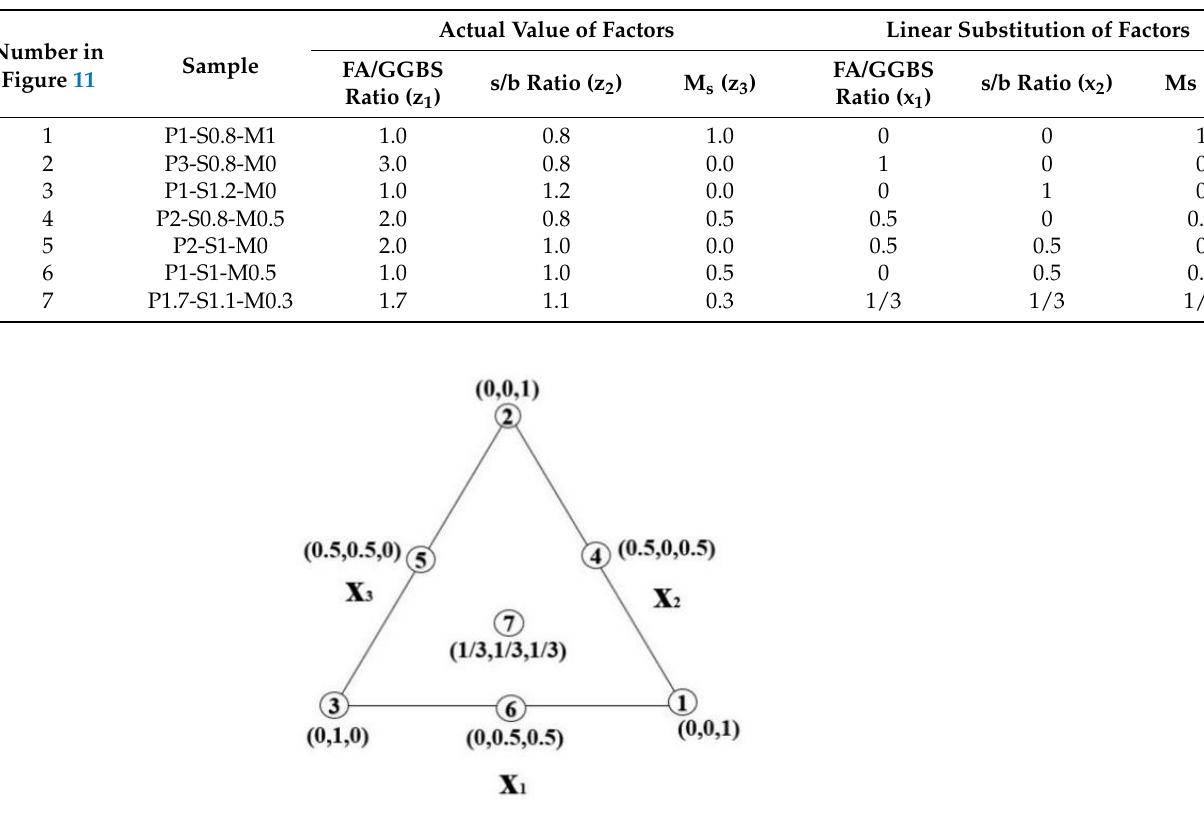
Figure 11. Seven test points of the simplex centroid design method.